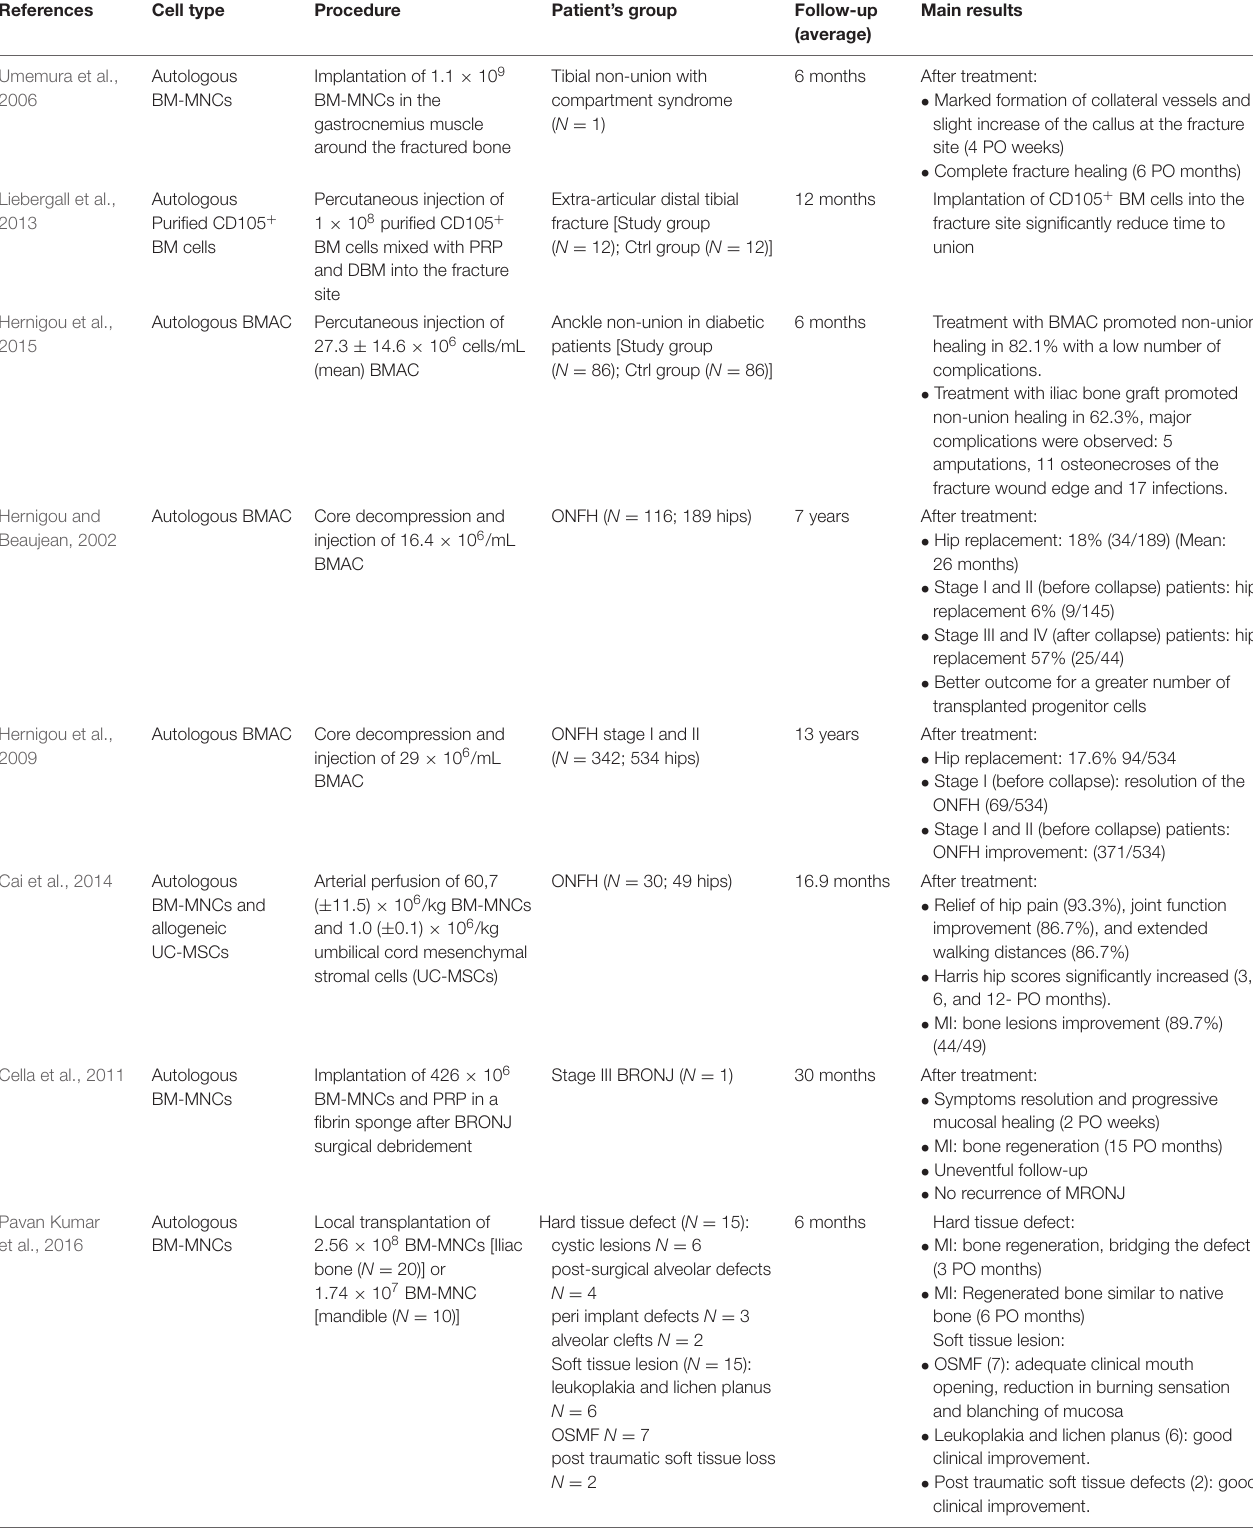
TABLE 1 | Summary of the Clinical studies using mesenchymal stromal cells for bone